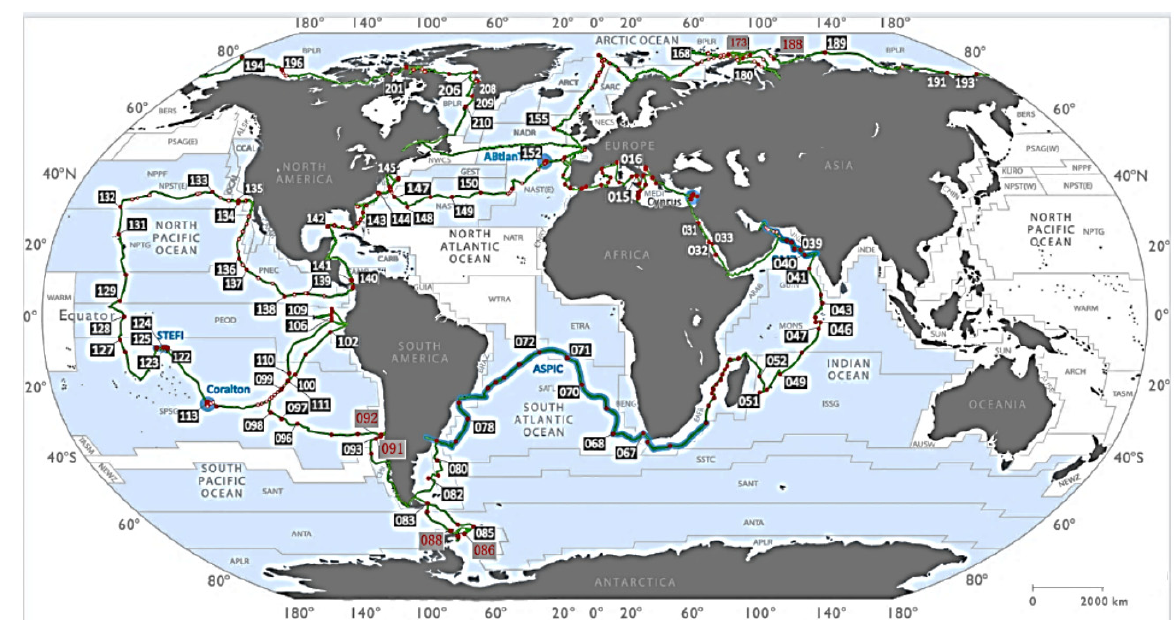
Figure 1. Sample distribution of Tara Oceans data. Adopted and modified from Pesant et al. (2015). The TOP water samples were obtained from 210 sites as marked with red dots. Total 102 sites had complete datasets for the DCM layer.